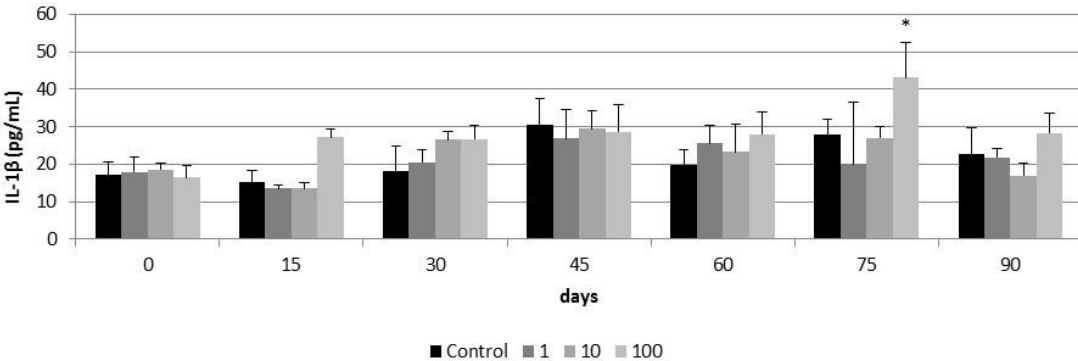
Figure 13. IL-1 β release in control airway epithelia and in airway epithelia exposed for 90 days to different concentrations of CeO 2 -NPs (1, 10, and 100 µ g/cm 2 ). Exposures were performed every two weeks for three months. Results are expressed as means ± SD of five replicates per tested condition and one assay ( n = 5). The asterisk indicates significant differences with respect to the untreated control cells ( p < 0.05).